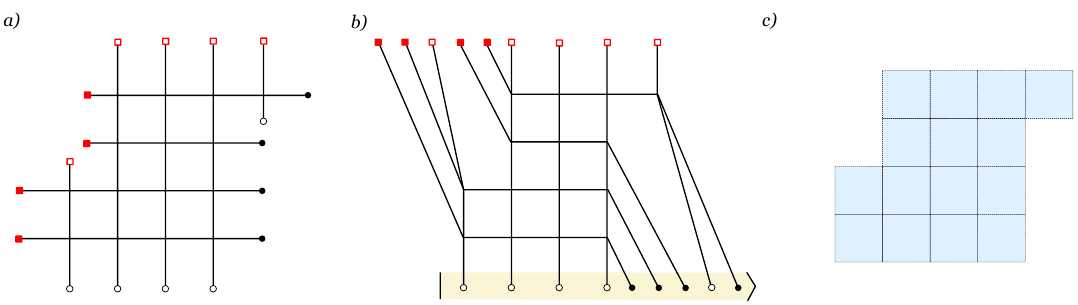
Figure 3 . Fishnet integrals of skew shape λ/µ . Fields of the same type that lie on a same vertical or horizontal segment are set at the same space-time point. a) Integral with skew shape λ = { 5 , 4 , 4 , 4 } , µ = { 1 , 1 , 0 , 0 } , appearing at order g 15 in Fishnet CFT. b) The limit where the position of fields X, Z coincide, and the same for ¯ Z, ¯ X . We highlight the initial ket of the stampede process. c) Skew Young diagram associated with the